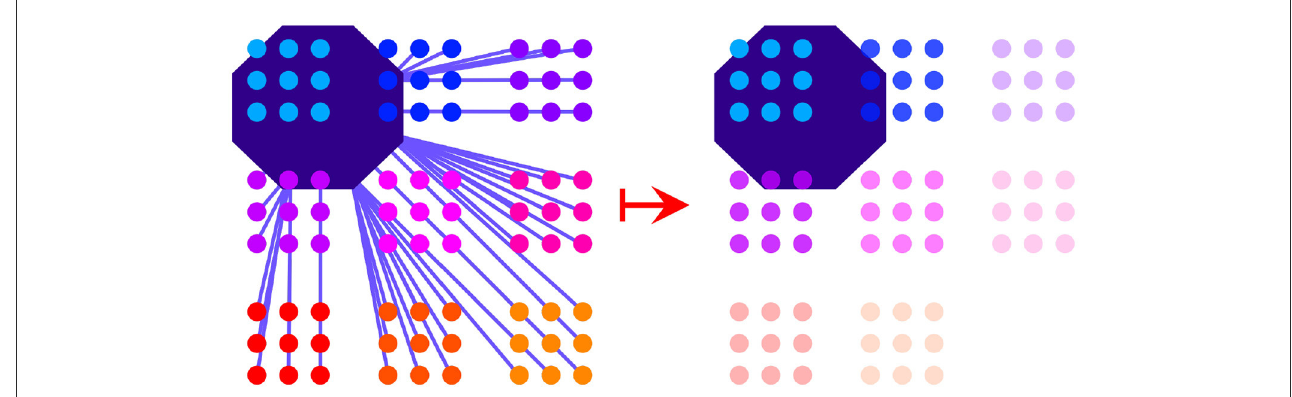
FIGURE3 The activation process in motor space is shown. The region of the silhouette at a particular time step activates junctures that are overlapping with the region or less than a certain distance away from it (distances shown by purple lines, left ). Activation spreads evenly within a cluster. Activation levels are determined by the distances of the junctures to the silhouette region. Activation strength of clusters is depicted by the relative transparency-opacity of the clusters (right) .